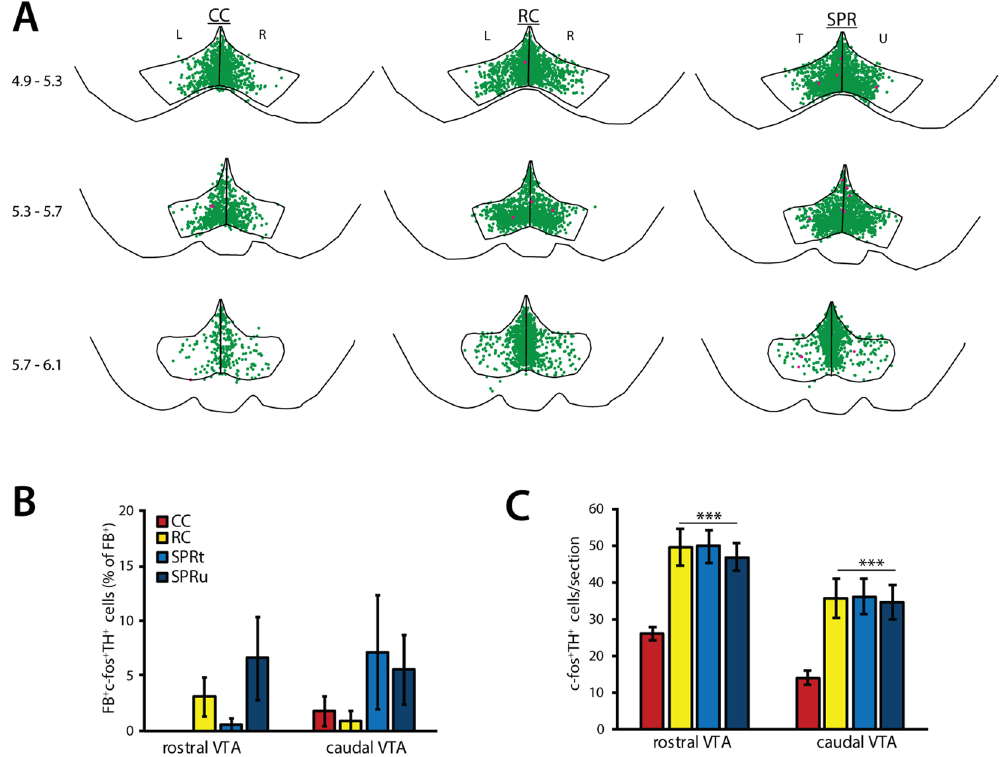
Figure 4. c-fos expression in dopaminergic neurons during plateau task execution (PL, N = 8 per group). SPR = single pellet reaching, RC = reward control, CC = cage control. T = trained, U = untrained, L = left, R = right hemisphere. Values are mean ± s.e.m. ( A ) Superposition of TH + c-fos + (green) and FB + TH + c-fos ++ (pink) neurons in VTA derived from 8 animals (2 sections per position per animal). Numbers indicate position relative to bregma. ( B ) Number of FB + TH + c-fos + neurons in rostral and caudal VTA sections. ( C ) Number of TH + c-fos + neurons in rostral and caudal VTA sections. ( *** p ≤ 0.001 in Tukey’s HSD